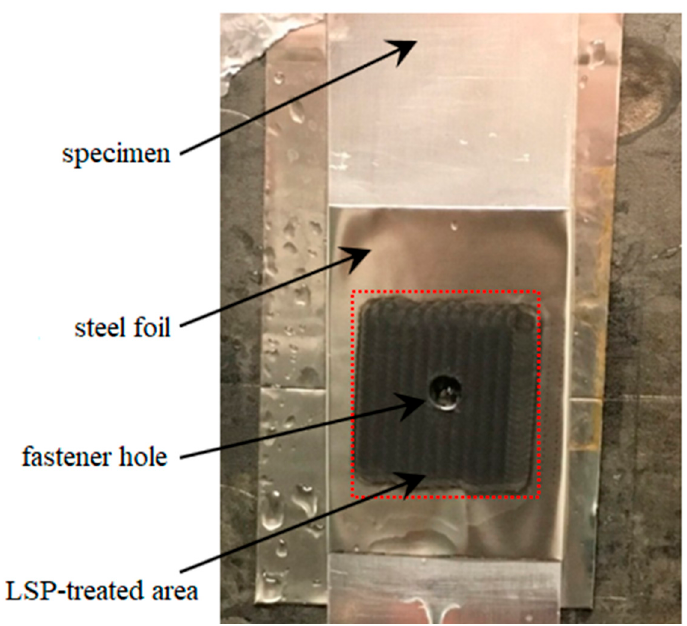
Figure 5. A representative specimen with a fastener hole after LSP treatment.